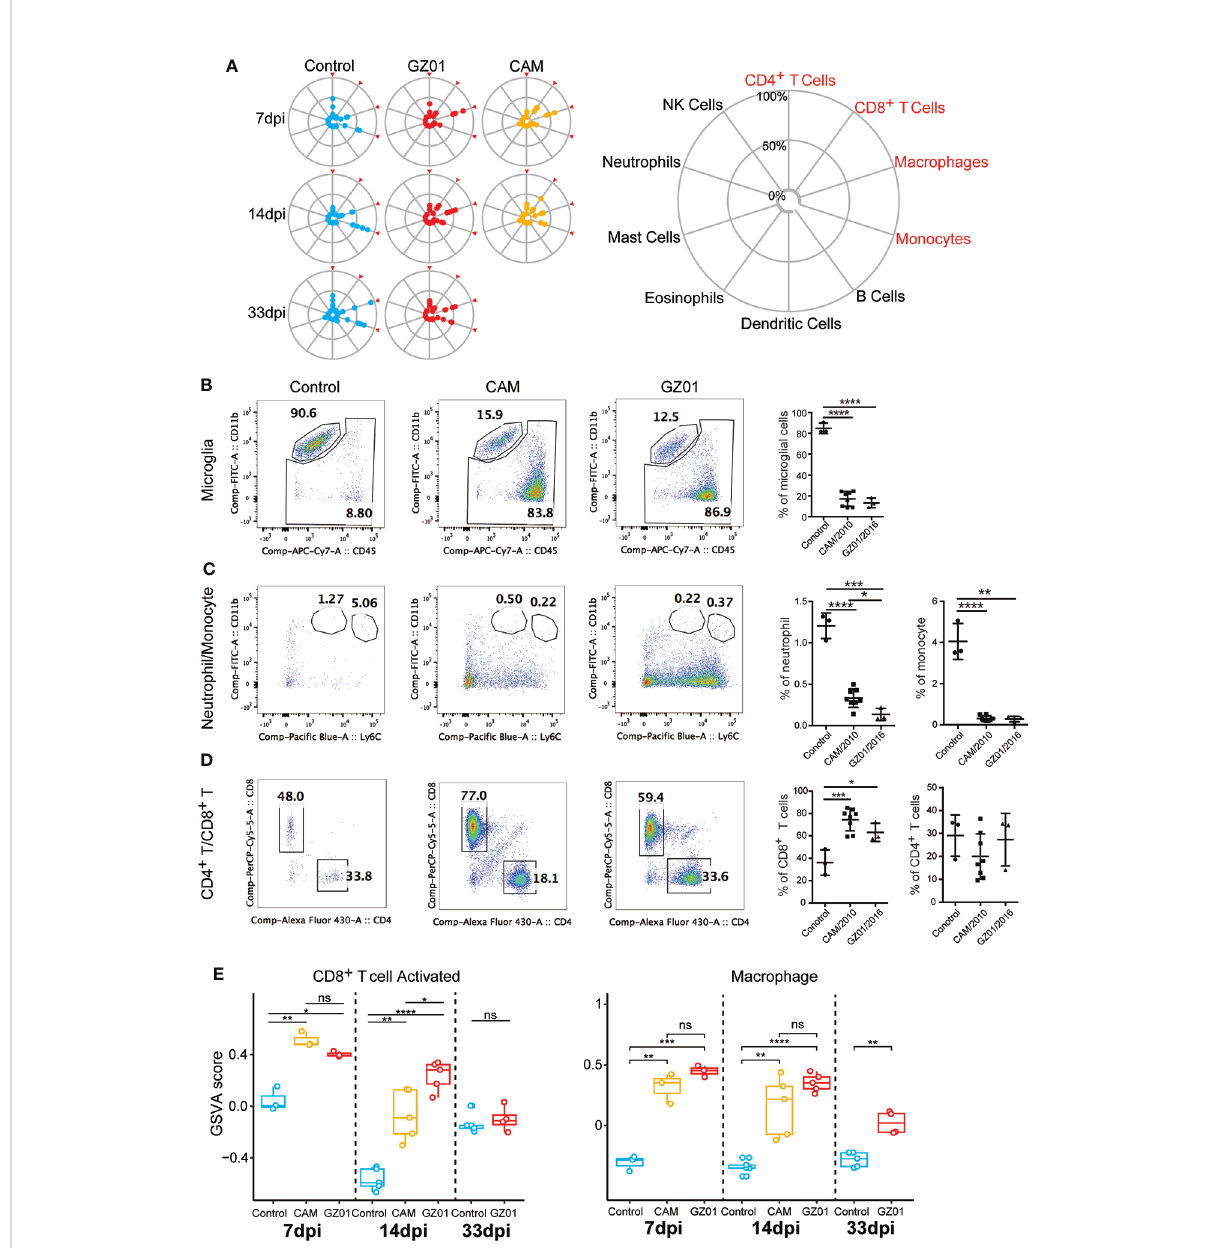
FIGURE 3 Immune cell pro fi les of mice infected with ZIKV and Control. (A) , Zika infection leads to activation of CD8+ T and microglia cells. A, The proportions of the ten immune cell types investigated. The immune cell ratio was calculated using expression data from the immuCC website. (B – D) , Flow cytometry immunophenotypic analysis of a case of microglia, monocyte, CD4, and CD8 in Control and mice infected with ZIKV. (E) , Comparison of the enrichment scores of immune cell subtypes in different infection groups by GSVA.*P<0.05; **P<0.01, ***P<0.001, ****P<0.0001, ns, not signi fi cant (two-tailed unpaired Student ’ s